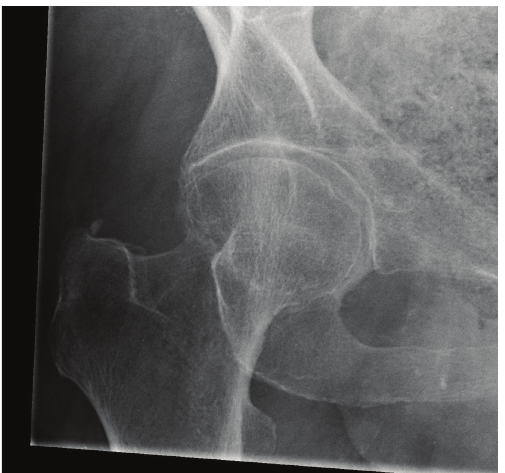
F 3: Example of a femoral neck fracture shown on the Bristol hip view.